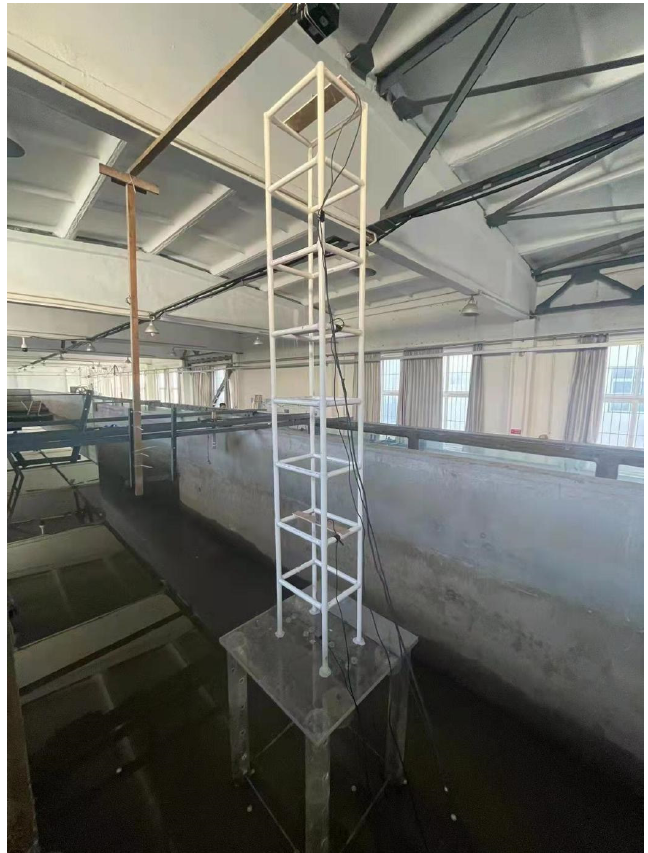
Figure 5. Photo after the preparation of model B.